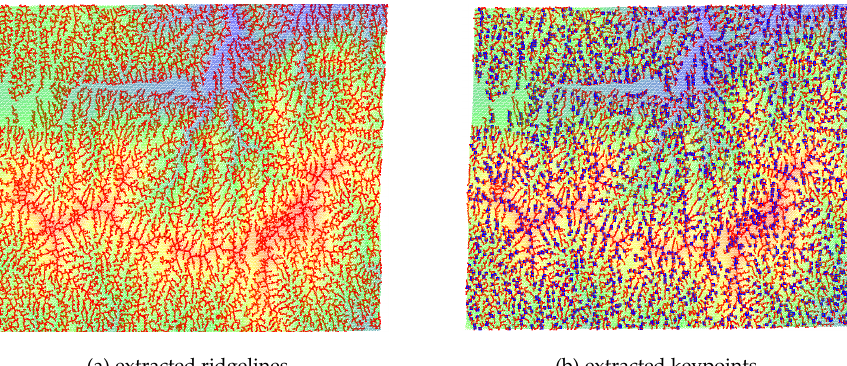
Figure 8. Results of keypoint extraction.